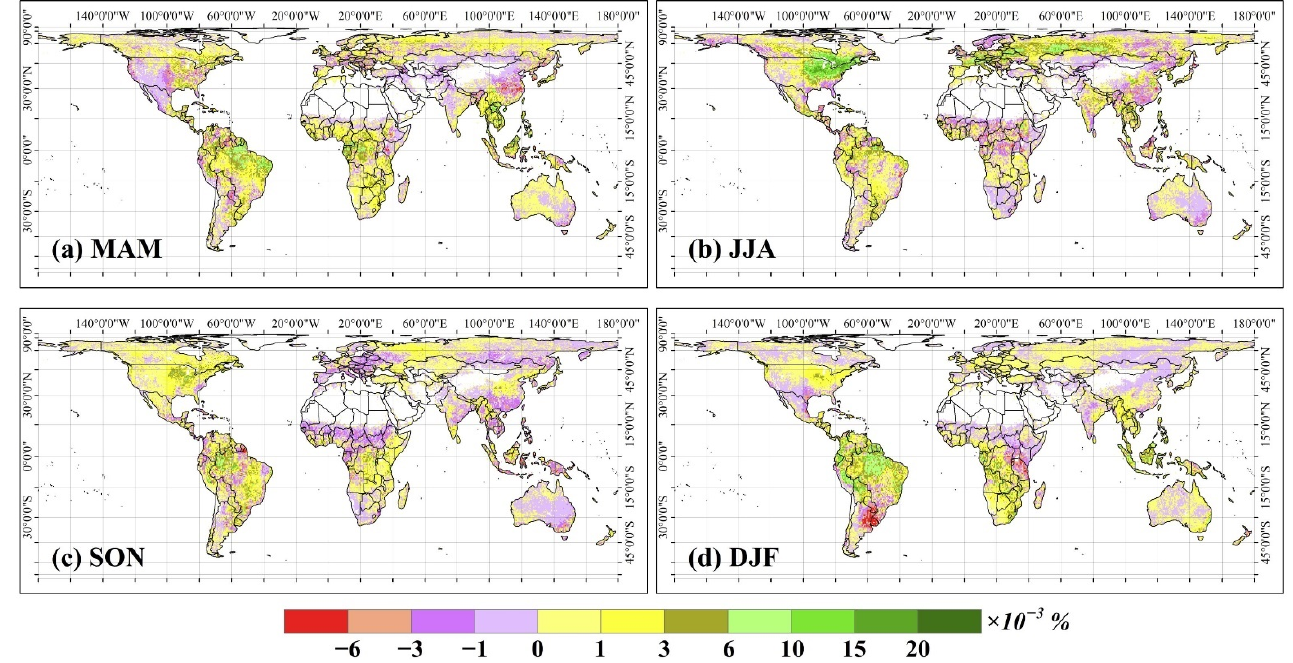
Figure 7. The spatial pattern of the contribution to IAV NEP in different seasons.